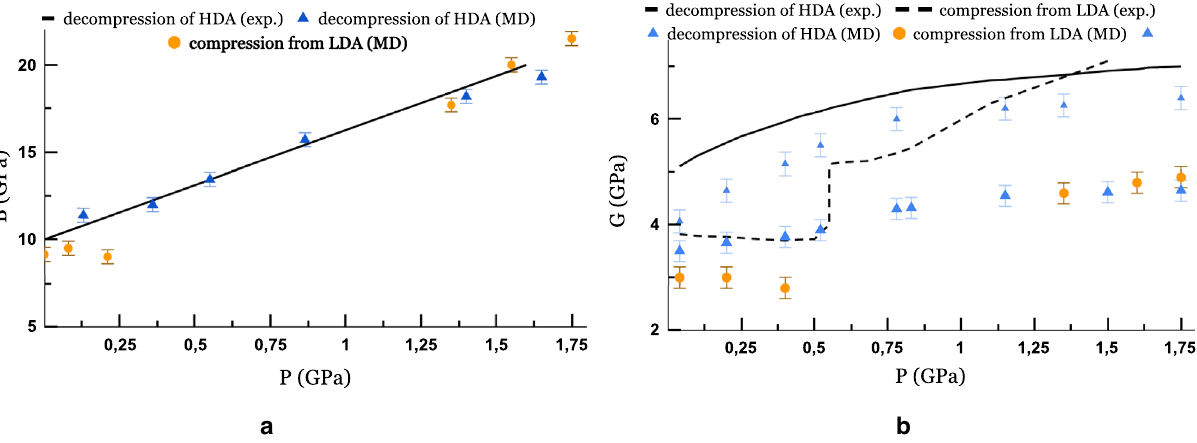
ba Figure 5. The pressure dependence of elastic moduli during isothermal ( T = 77 K ) compression and decompression at a compression rate 0.1 GPa/ns: ( a ) the bulk modulus, ( b ) the shear modulus. The dotted line corresponds to the experimental data during LDA compression at 110 K. The small blue symbols correspond to 10 s − 1 the results of the calculation with a higher shear rate of 5 · 10 during decompression of HDA.